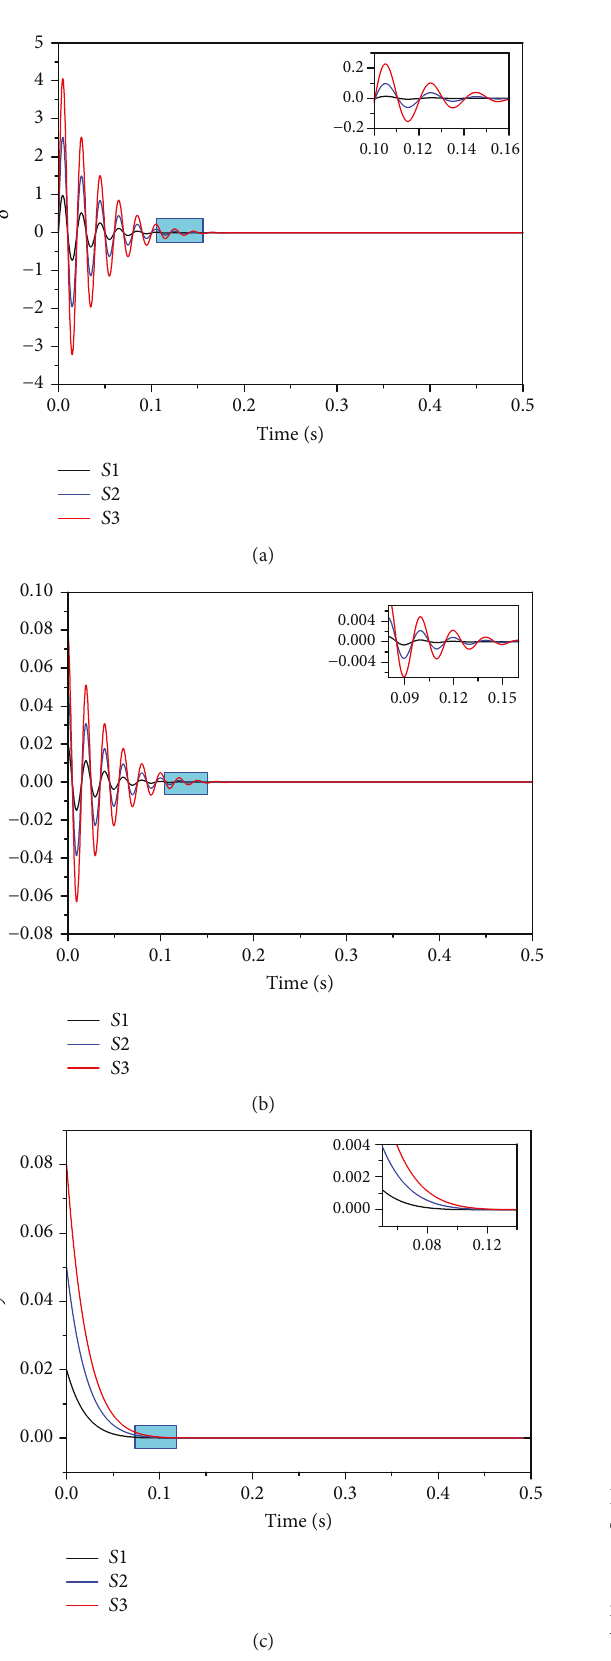
Figure 3: The response of the system with the di ff erent S .